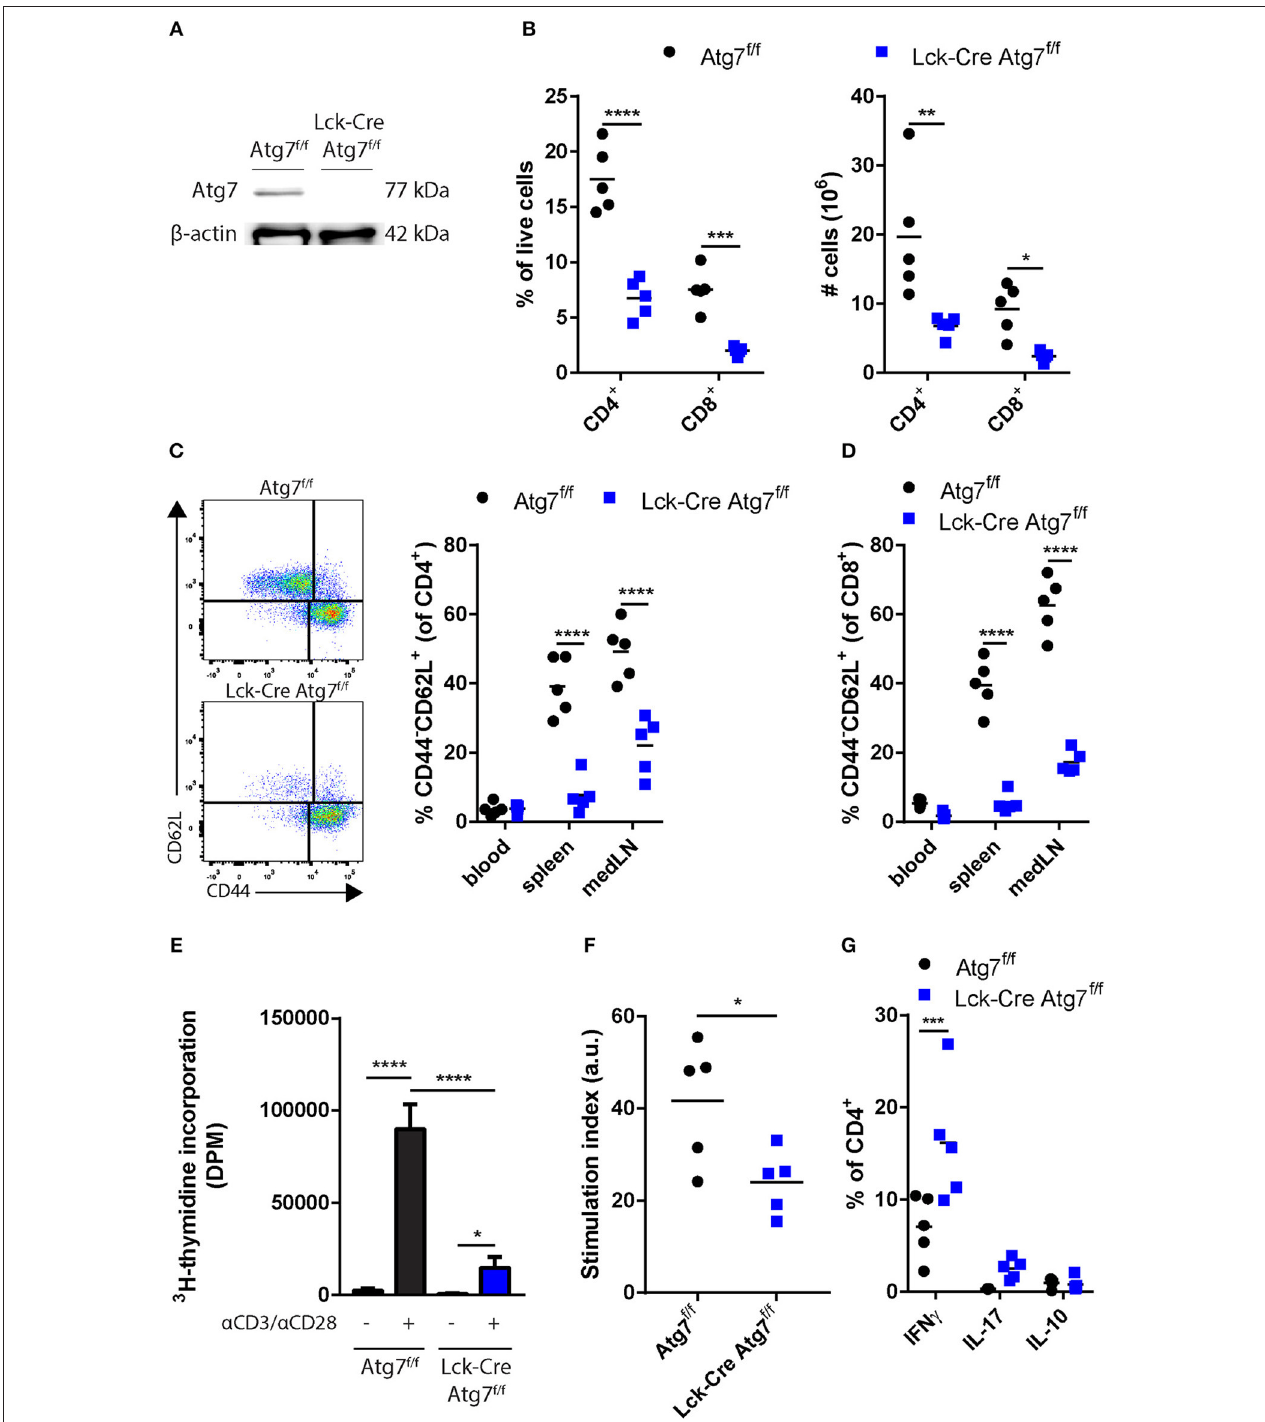
FIGURE 1 | Effect of Atg7 deficiency on CD4 + and CD8 + T cells. (A) Immunoblot of Atg7 in CD4 + T cells. β -actin was used as a loading control. (B) Percentage and numbers of CD4 + and CD8 + cells in the live lymphocyte fraction of spleens of indicated genotypes. (C) Gating and percentages of naive T cells in the CD4 + compartment. (D) Percentages of naive T cells in the CD8 + compartment. (E) T cell proliferation in stimulated or unstimulated splenocyte cultures. Expressed as mean ± standard deviation. (F) Stimulation index as calculated by dividing DPM of anti-CD3/anti-CD28 stimulated splenocytes by the DPM of non-stimulated splenocytes for each genotype. (G) Quantification of cytokine producing CD4 + T cells. * p < 0.05, ** p < 0.01, *** p < 0.001, **** p < 0.0001.